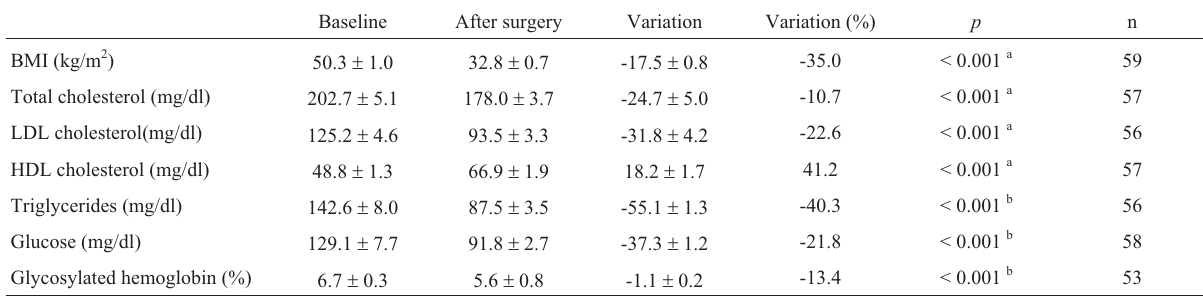
Table 3 - Evolution of anthropometric and metabolic parameters following bariatric surgery. Baseline After surgery